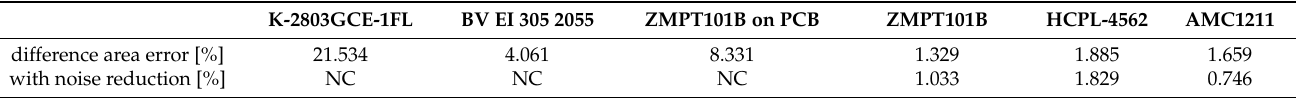
Figure 16. ( a ) Differences in instantaneous values of normalized and time-corrected input and output signals of one period for transformer K-2803GCE-1FL (black line) and ZMPT101B single-phase AC voltage sensor (grey line); ( b ) Differences in instantaneous values of normalized and time-corrected input and output signals of one period for fixture with HCPL-4562 optocouplers. The sharp jump in the plotted values near the zero crossing of the input signal (0, 0.01, 0.02 s) is clearly visible. A comparison of all test fixtures in terms of the ratio of the area bounded by the input and output waveforms relative to the area bounded by the input waveform and the time axis can be seen in Table 4. The difference area error values calculated according to Equation (6) for the normalized input and output waveforms with time-corrected source data are in the row labelled “difference area error”. The difference area error values for output waveforms for which noise or interference has been reduced by averaging according to Equation (7) are shown in the row labelled “with noise reduction”. (NC—not